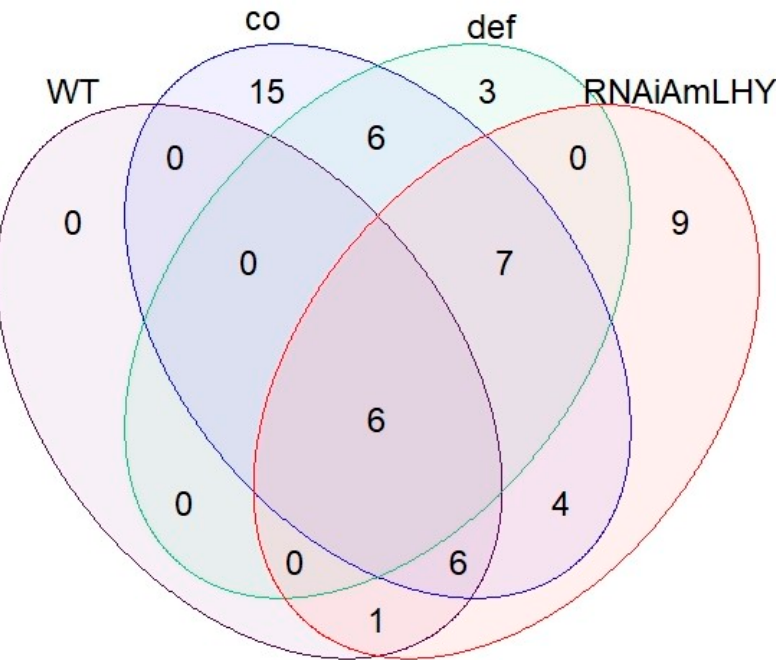
Figure 5. Venn diagram showing overlapping volatiles organic compounds detected in wild type (purple), co (blue), def nic (green) and RNAi:AmLHY (red) snapdragon flowers. These comprise 57 VOCs, i.e., the sum of profile and non-constitutive by quantity.